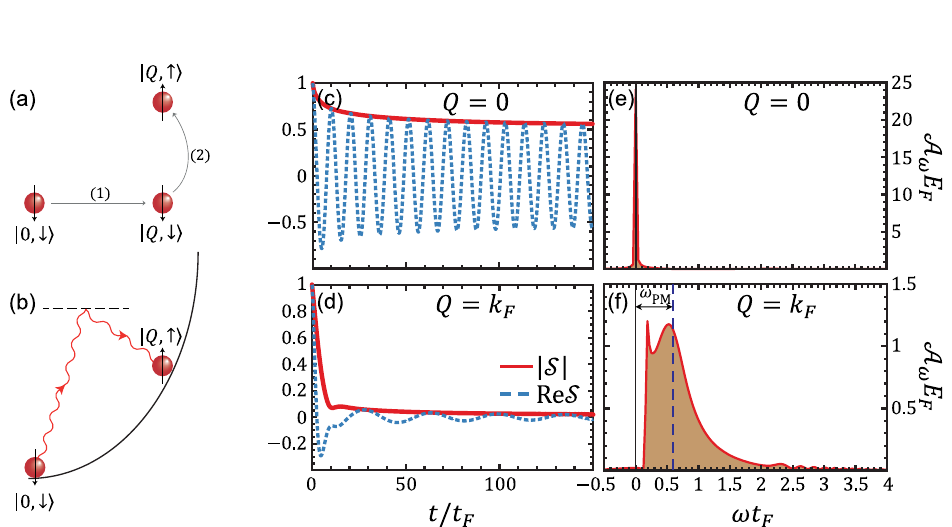
FIG. 3. (a),(b) Possible cold-atom setups. The initial wave function corresponds to j FS i ⊗ j 0 ; ↓ i , where the hyperfine state j ↓ i does not interact with the fermionic medium. (a) The impurity is first accelerated such that it acquires momentum Q ; subsequent rf pulse drives it into the hyperfine state j ↑ i strongly interacting with the host gas. (b) Alternatively, the two states j 0 ; ↓ i and j Q; ↑ i can be directly coupled by a two-photon Raman process. (c) – (f) The dynamical overlap function S ð t Þ and the impurity absorption spectra A ω for Q ¼ 0 (c),(e) and for Q ¼ k (d),(f). We shifted frequencies in (e) and (f) such that the zero value in both panels represents the F corresponding ground-state oscillations. For Q ¼ k , the Ramsey contrast j S ð t Þj demonstrates switching from initial rapid decay for F times t ≲ 10 t to the lasting regime of slow dynamics. This behavior reflects in A ω as it acquires a double-peak structure: The frequency F of the first peak is close to that of the ground-state oscillations, whereas the second peak corresponds to the collective mode ω Parameters are the same as in Fig. 1, except N ¼ 251